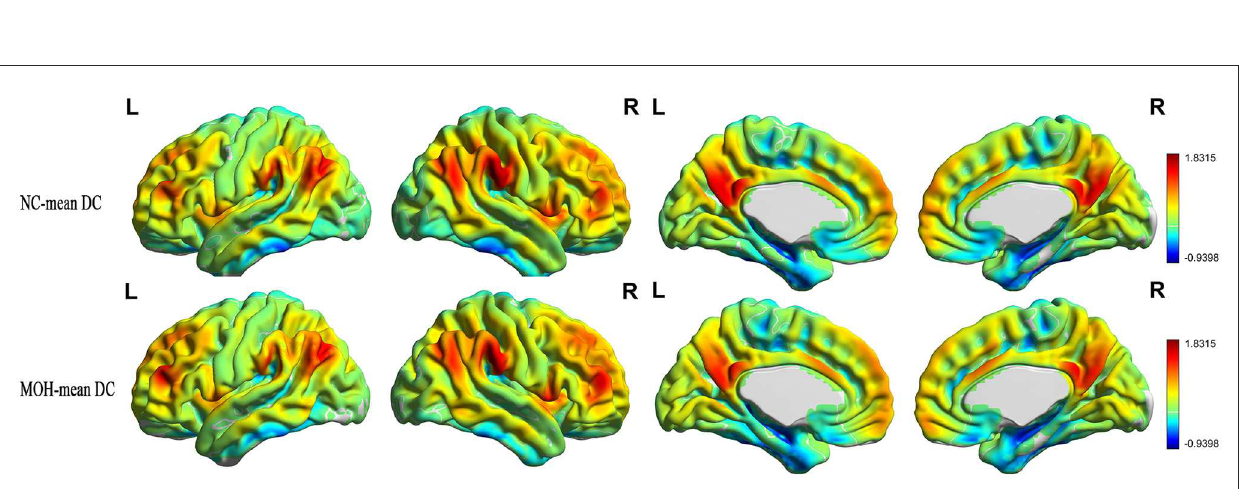
FIGURE8 Mean DC in normal controls (NCs) and patients with medication-overuse headache (MOH) over the entire gray matter